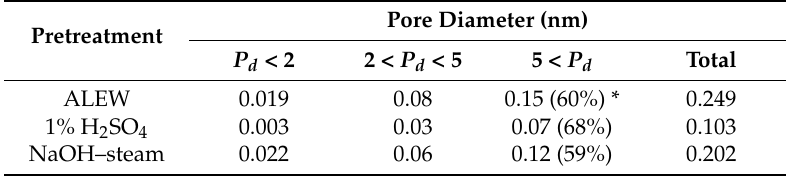
Table 5. Effects of pretreatment conditions on micropore volumes of the Eucalyptus